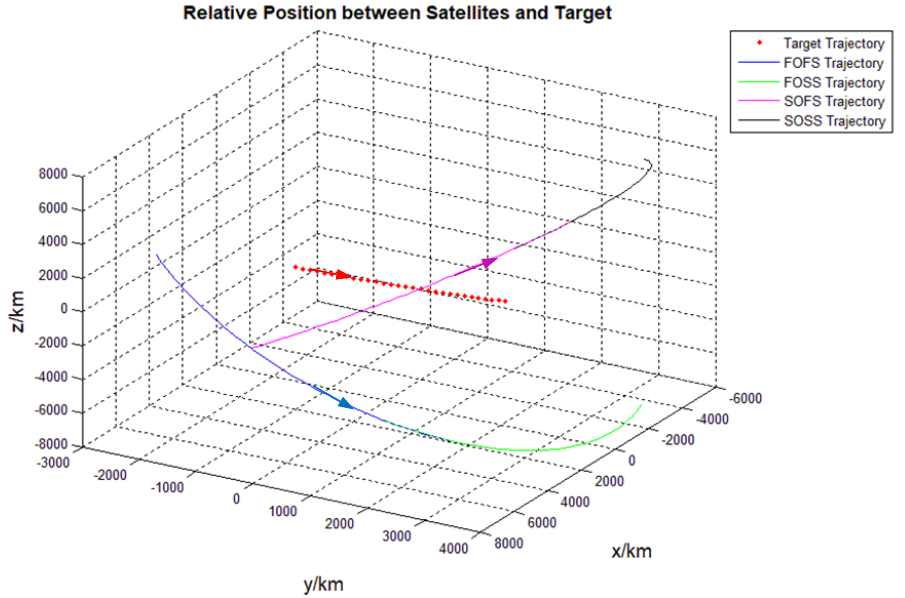
Figure 16. Selection of orbit planes and satellites for target3.